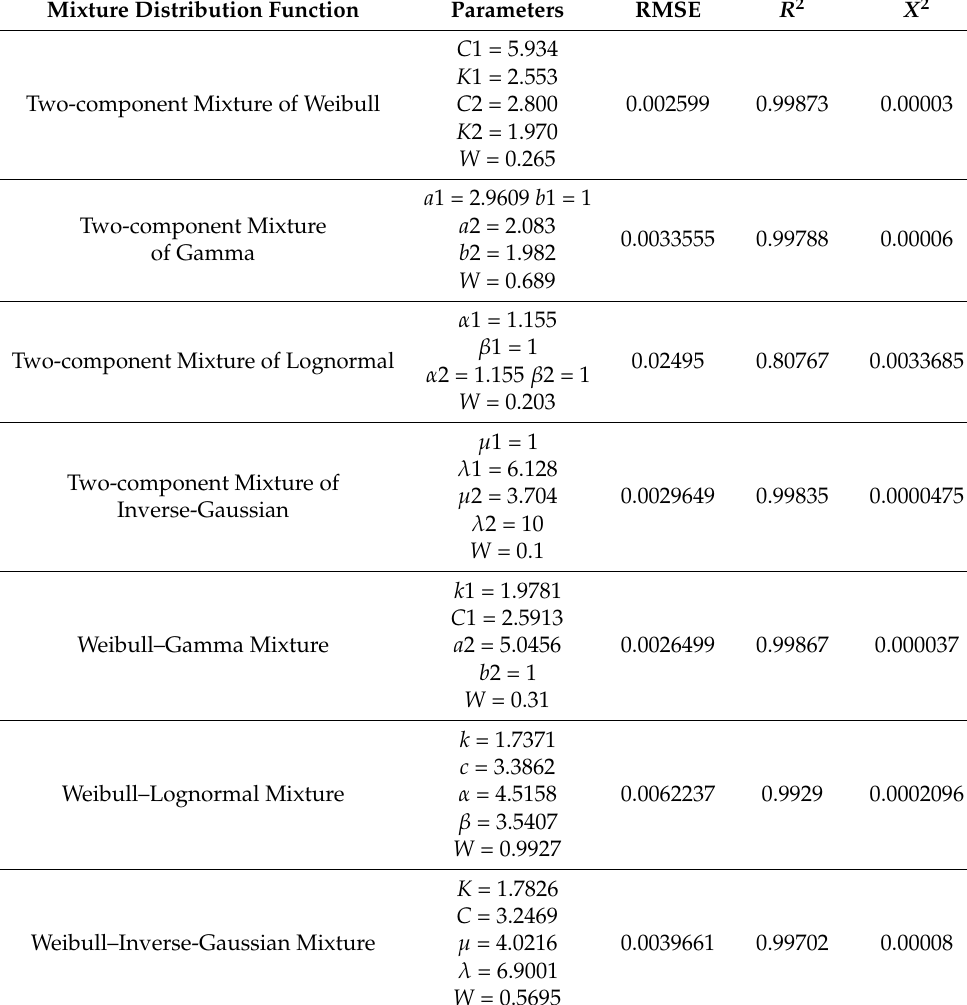
Table 2. Probability distribution parameters for the two-component mixture PDFs in the wind speed